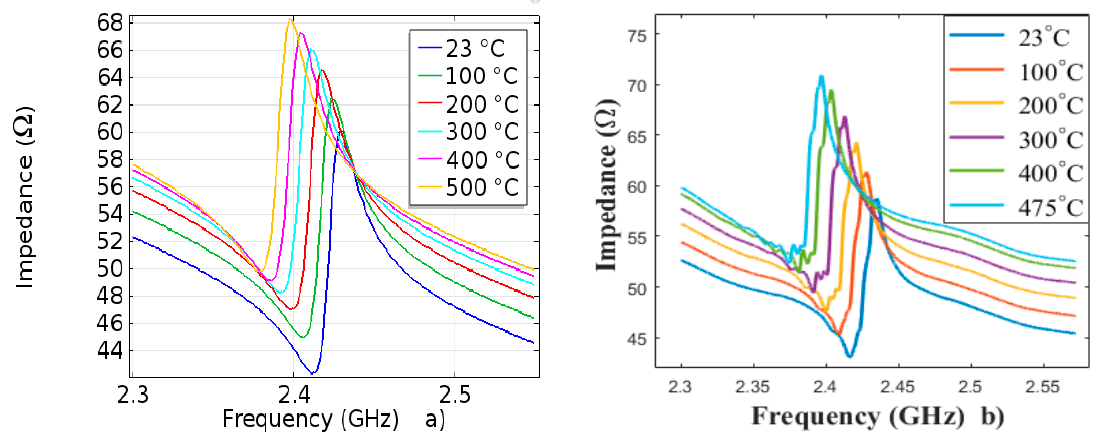
Figure 5. Variations in impedance as a function of temperature: ( a ) simulation ( b )